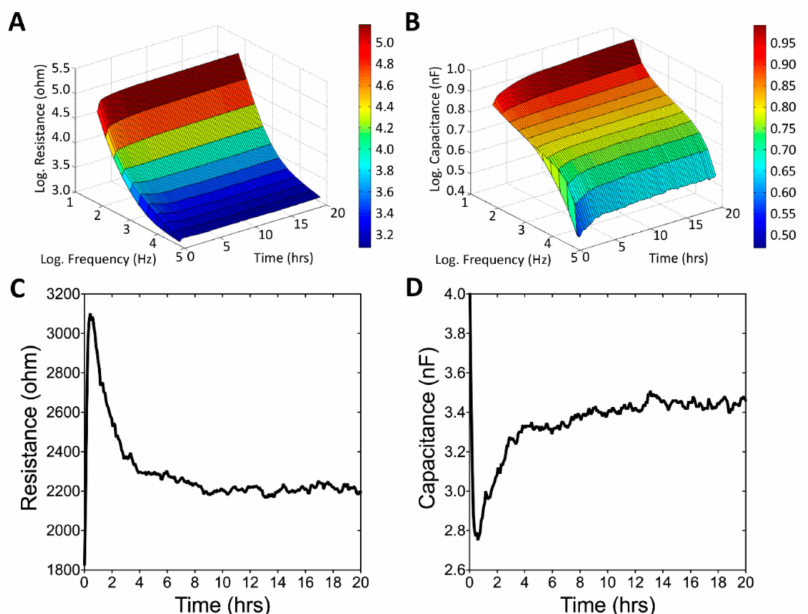
Figure 3. ECIS measurement of U-87 MG cell attachment and spreading. At time zero, U-87 MG cells were seeded in an ECIS well giving a final cell density of 9E4 cells per cm 2 . Three-dimensional representation of the changes in resistance ( A ) and capacitance ( B ) as a function of frequency and time during the attachment and spreading of U-87 MG cells on microelectrodes. ( C ) Changes in resistance as a function of time measured at 4 kHz. ( D ) Changes in capacitance as a function of time measured at 64 kHz.